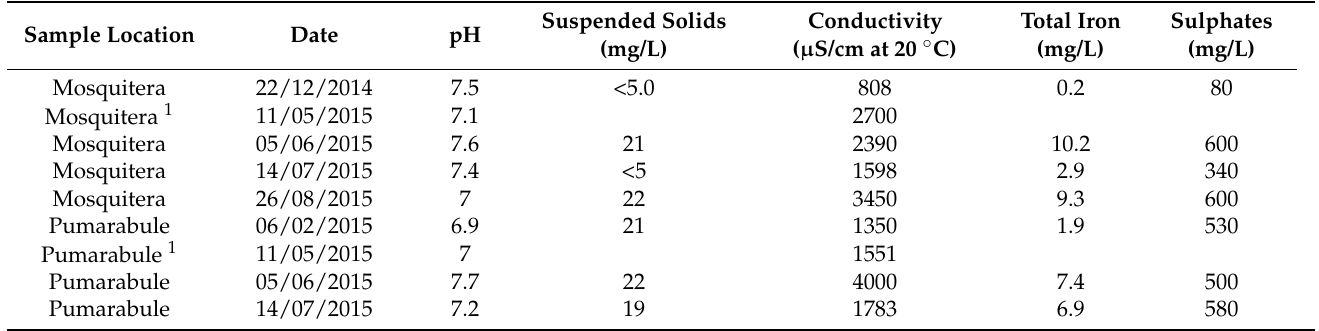
Table 1. Water quality analyses at the Mosquitera and Pumarabule mines.